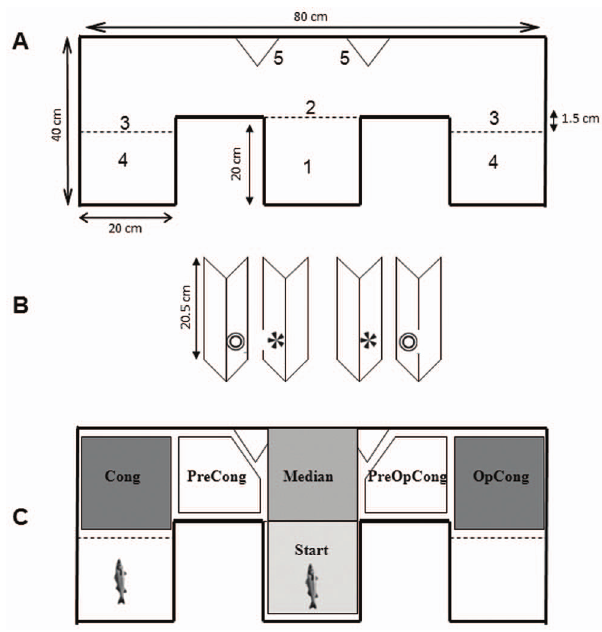
Figure 1. A. Schematic representation of the T-maze apparatus. Dotted lines are transparent Plexiglas walls, continous lines are white opaque plastic. The bottom of the maze is made of transparent Plexiglas. 1.Start box; 2. Removable transparent plexiglass wall; 3. Not removable transparent Plexiglas walls; 4. Compartment strictly waterproof where congeners were placed. 5. White plastic support for laminated printouts 2-D objects. B. Detail of the 4 supports and the 2-D objects. C. Virtual zones delimitation on the bottom of the maze defined for the video recordings analysis. Example of a trial where the tested fish is shown in the start box and the reward fish is shown on the left arm of the maze.